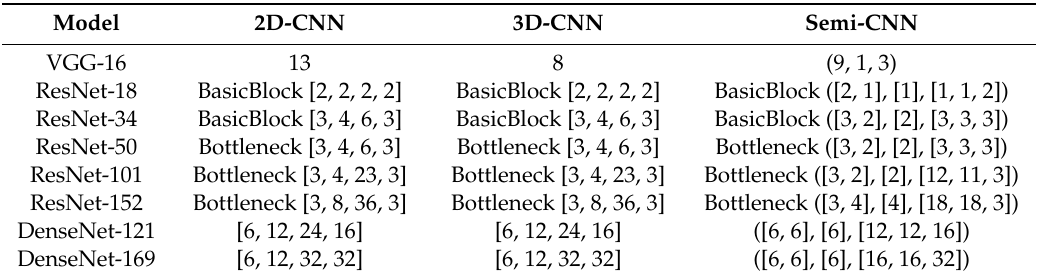
Table 1. Configuration comparison for 2D, 3D and semi-CNN architecture, using base model VGG, ResNet and